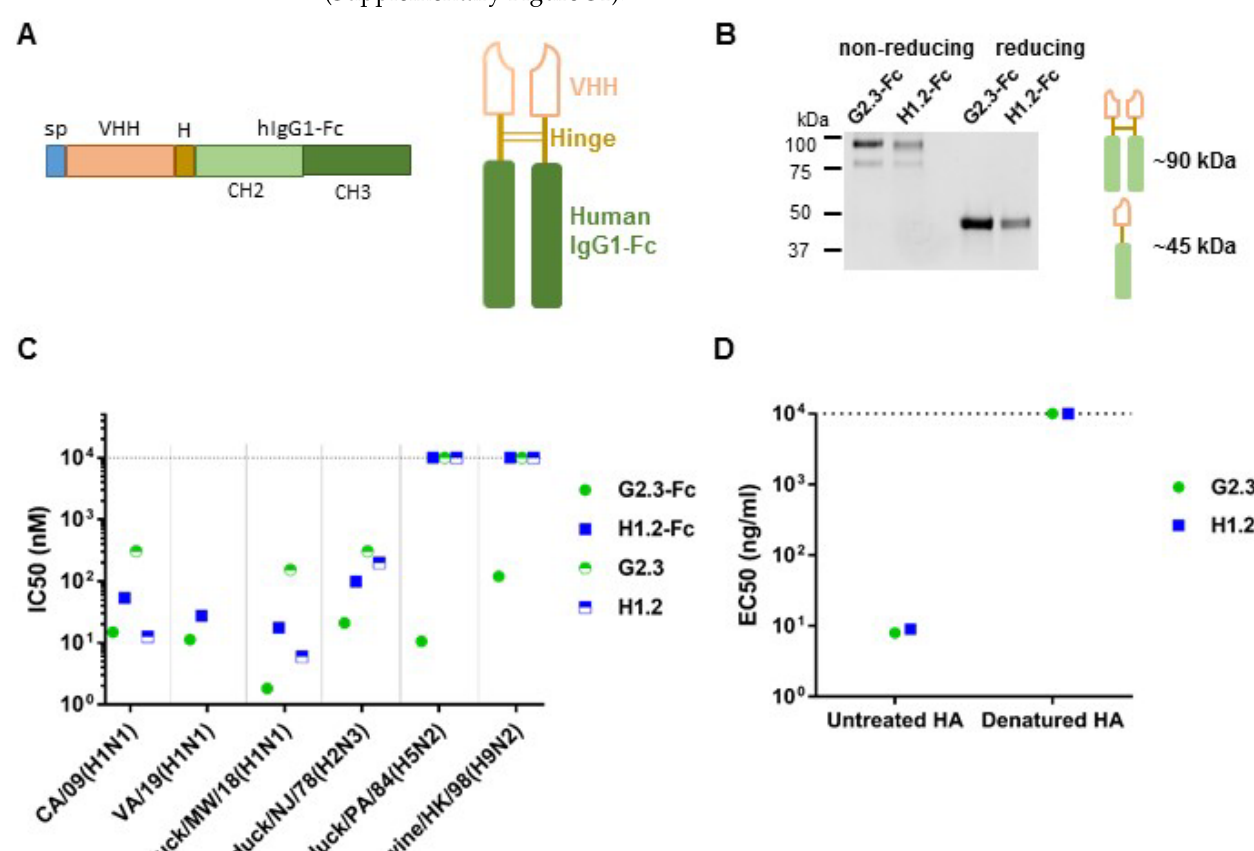
Figure 1. Characterization of G2.3-Fc and H1.2-Fc. ( A ) A schematic representation of the VHH-Fc constructs. sp—signal peptide, H—hinge, CH2 and CH3—heavy chain constant domains of hIgG1-Fc. ( B ) Analysis of purified VHH-Fc using SDS–PAGE. Theoretical molecular weights for VHH-Fc under reducing and non-reducing conditions are ~45 kDa and 85–90 kDa, respectively. ( C ) Neutralizing activity of VHH and VHH-Fc in vitro against Group 1 IAV. The neutralizing potency of VHH against influenza VA/19 (H1N1) virus was not tested. IC 50 is expressed in nanomolar concentration and was measured in quadruplicate. ( D ) EC 50 values determined in ELISA show binding of VHH-Fc to untreated and denatured rFL HA (A/California/04/2009). EC 50 values are expressed in nanogram per milliliter. Dotted lines indicate the absence of activity.